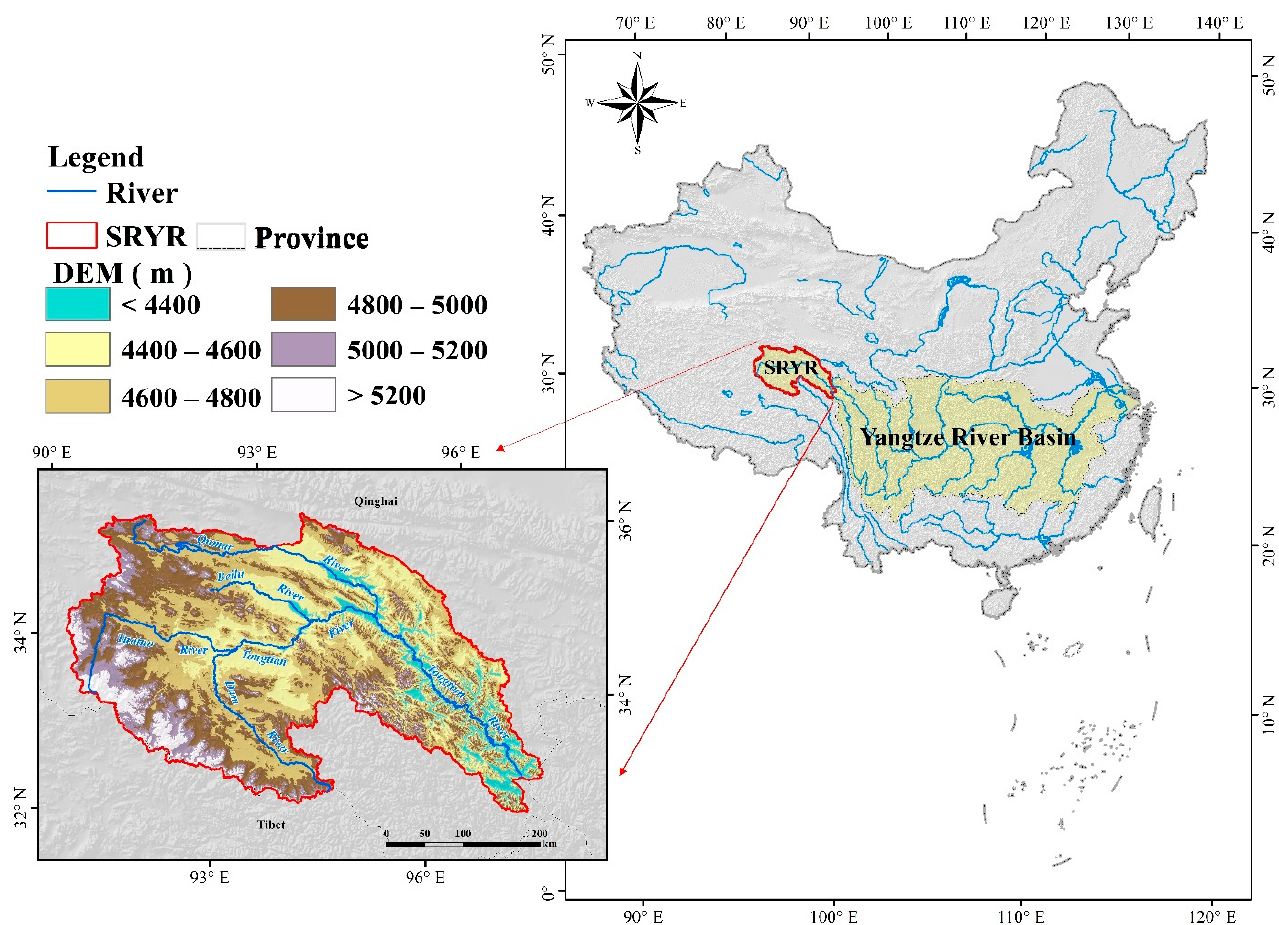
Figure 1. Geographical location of the SRYR.